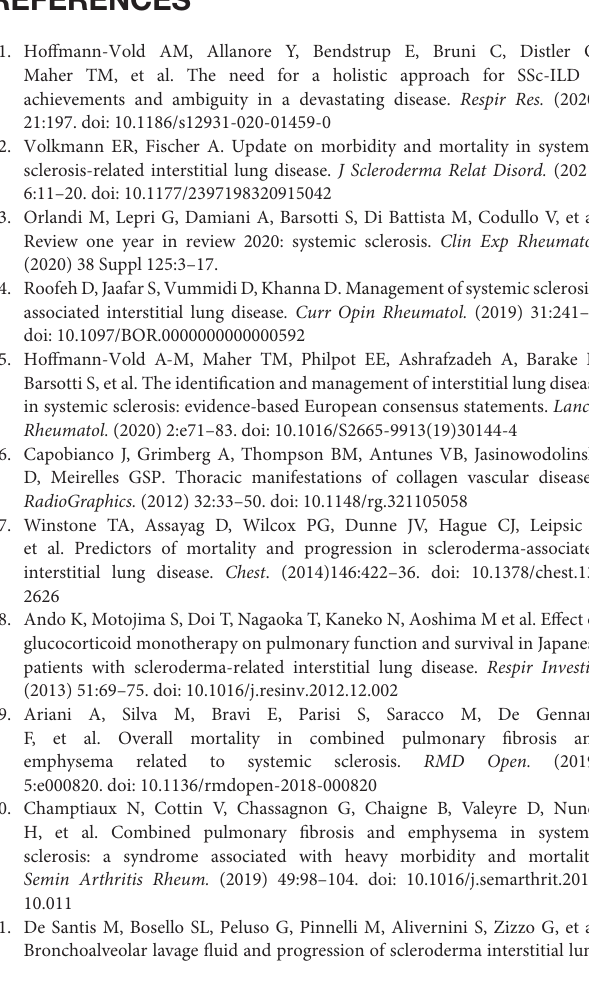
Supplementary Figure 1 | Risk of bias and applicability concerns, based on QUADAS-2 (http://www.bristol.ac.uk/population-health-sciences/projects/ quadas/quadas-2/). Supplementary Data 1 | Papers not included (only partially meeting inclusion criteria), but relevant for the discussion, grouped by reasons of rejection. Supplementary Data 2 | Definitions of investigated predictors.